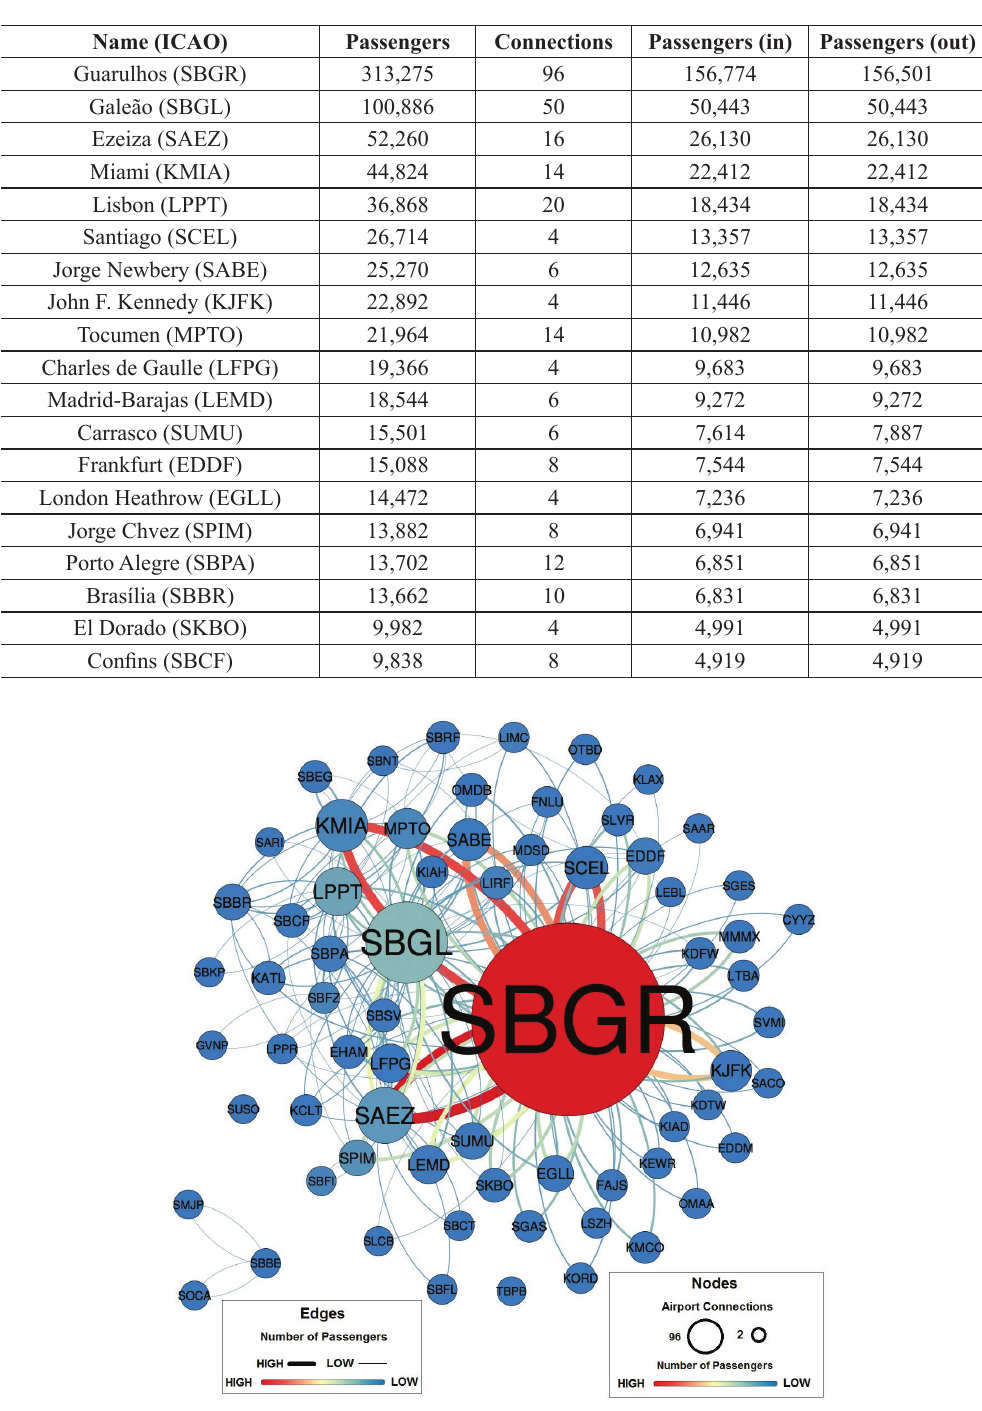
TABLE XV Top-20 - Maximum Number of Passengers - International Flights.